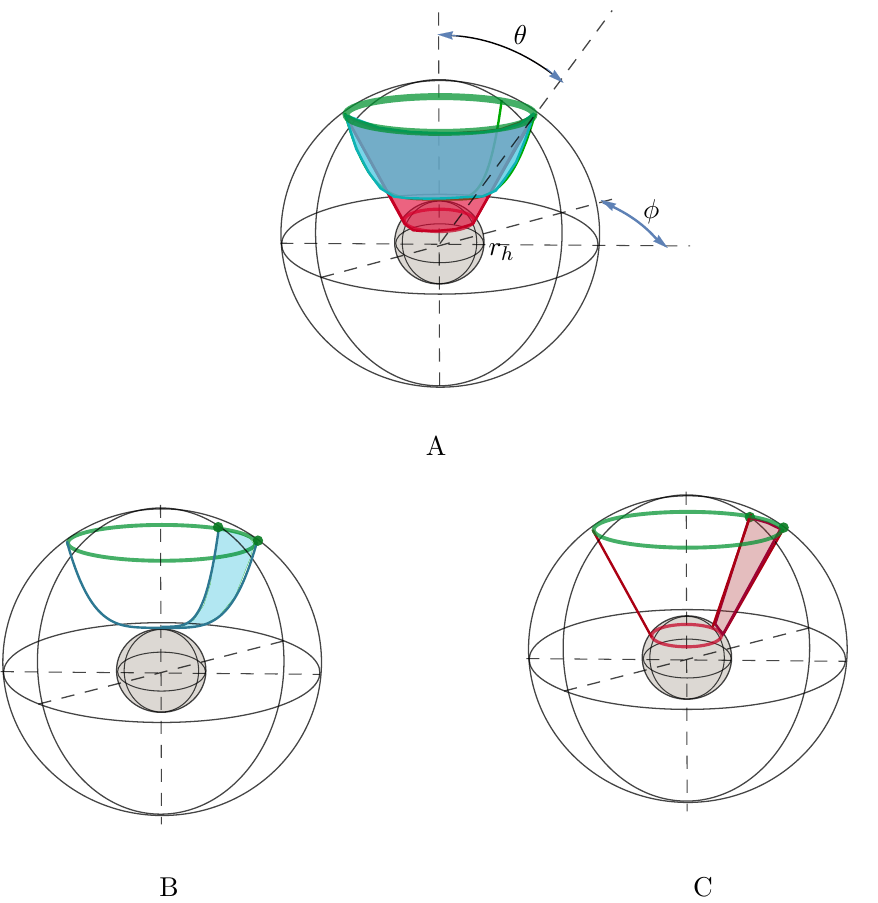
Figure 1 . Heavy quark moves on the boundary of AdS 5 having topology R 1 × S 3 ( R 1 and the third special coordinate, the angle ψ are suppressed). It moves along a circle with fixed θ 0 and varying φ . A) We consider the Wilson loop fixing θ = θ 0 and 0 ≤ φ ≤ 2 π (the small green circle). The blue surface is an extremal surface that ends on trajectory of a heavy quark and touches the horizon of a black hole. The red surface is an analog of the disconnected holographic surface for planar BH calculations. B) The string suspected from the boundary and touched the horizon. C) The straight string ending on the